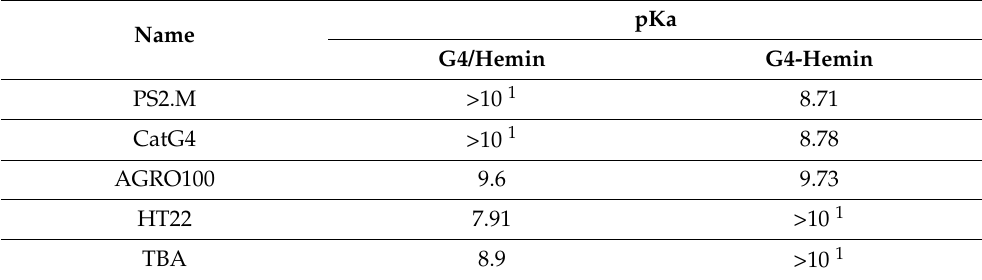
Table 3. The pKa values determined for DNA/hemin complexes and DNA-hemin